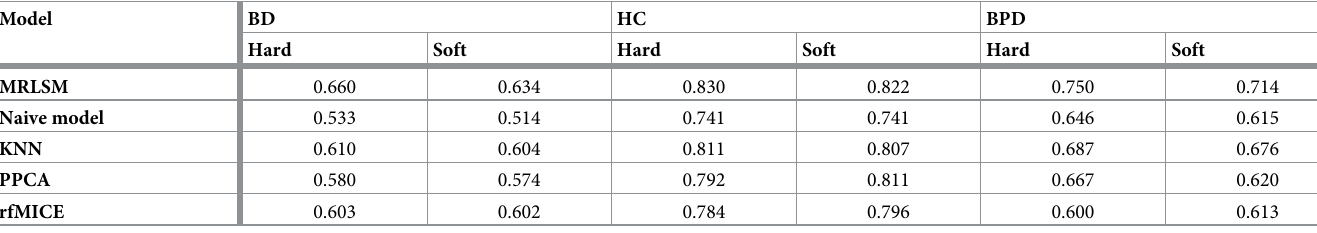
Table 4. F1 scores for group classification under hard and soft voting schemes using different models.